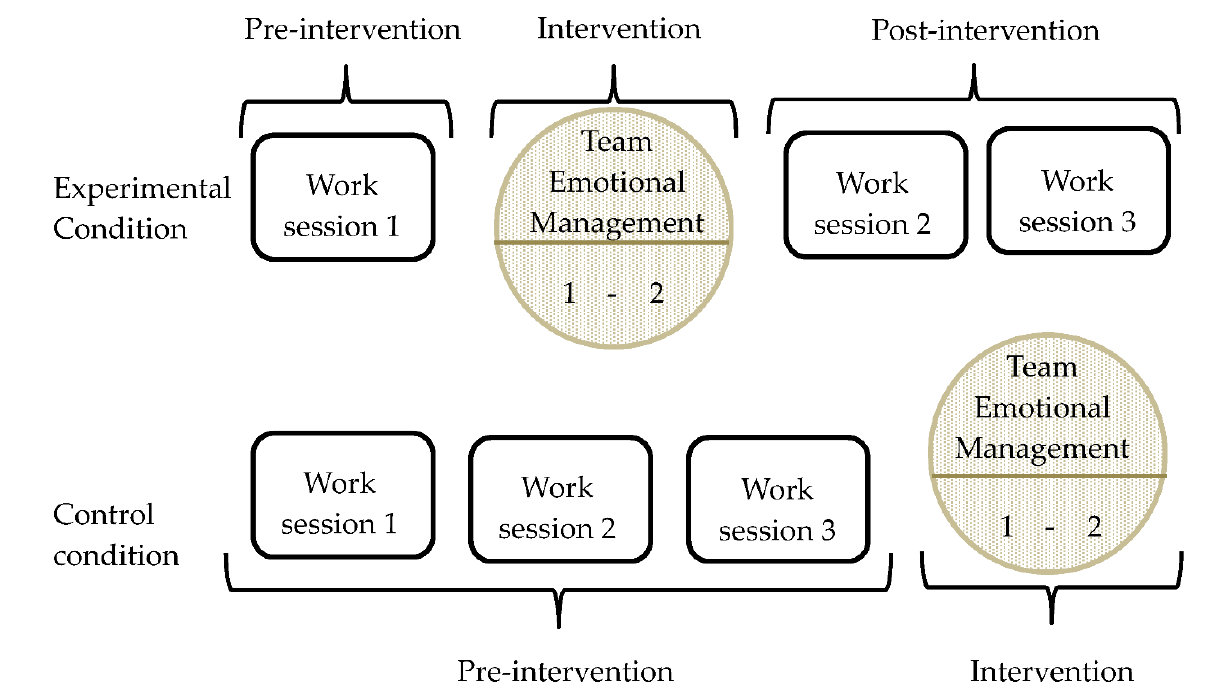
Figure 1. Experimental design of the study.